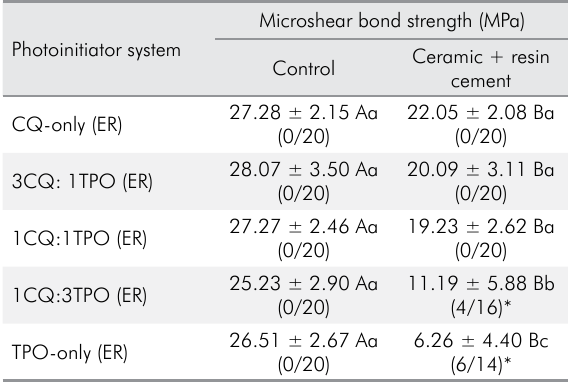
Table 5. Microshear bond strength means (± standard deviation) for SE experimental adhesive systems with and without interposed ceramic veneer and resin cement